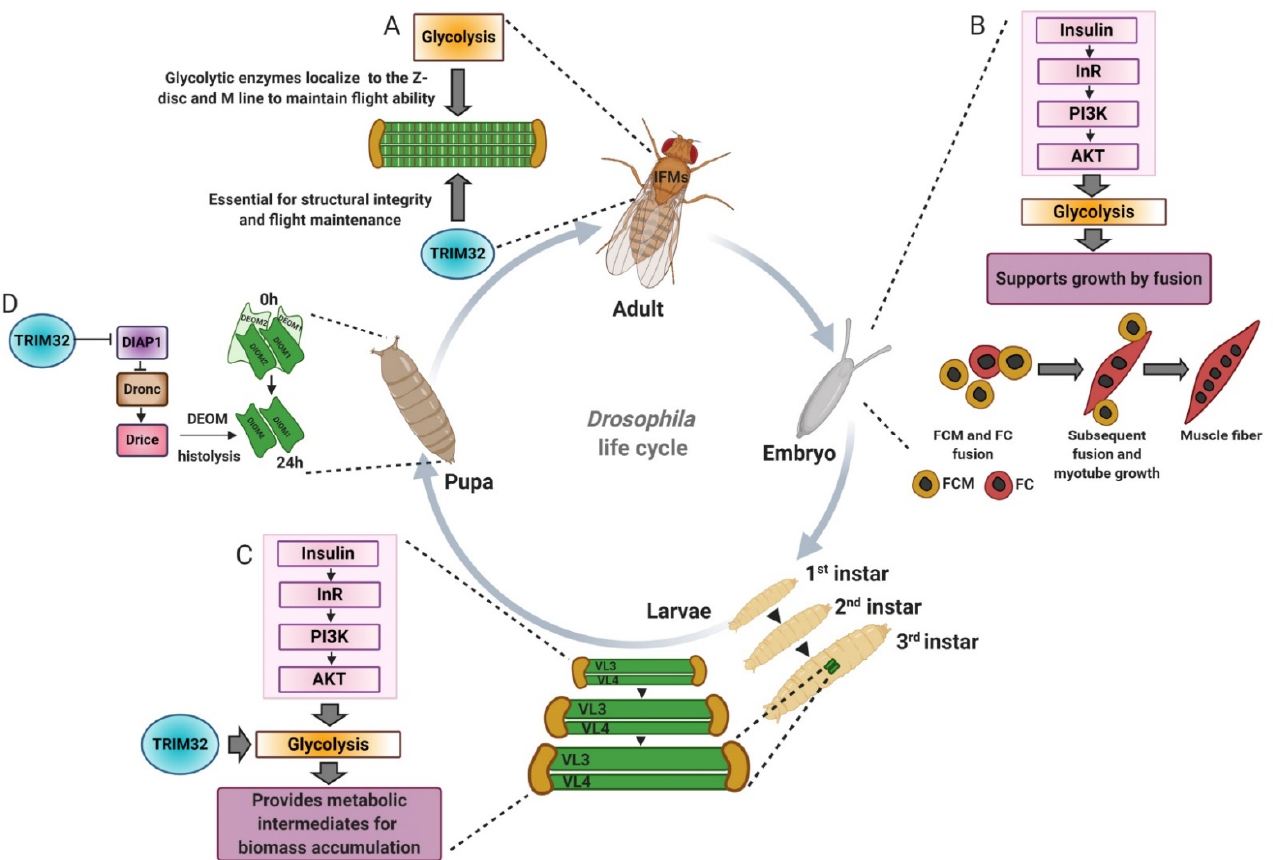
Figure 6. The Drosophila model has been instrumental in understanding how TRIM32 and glycolysis regulate cell growth and cell death. ( A ) Glycolytic enzyme localization to the Z-disc and M-line in Drosophila adult indirect flight muscles (IFMs) is required for flight maintenance. TRIM32 is also required to maintain the structural integrity of the IFMs, possibly by mediating the subcellular distribution and/or stability of glycolytic enzymes. ( B ) Insulin acts upstream of glycolysis to promote muscle growth by fusion during embryonic development. ( C ) TRIM32 directly acts on glycolytic enzymes to regulate protein levels and/or protein localization, which in turn allows for high glycolytic flux in larval tissues undergoing massive cell growth. ( D ) Much like that of XIAP, TRIM32 regulates the levels of DIAP1 to control the apoptotic death of a set of muscles that undergo histolysis during pupal development. DEOM, dorsal external oblique muscle. FCM, fusion competent myoblasts. FC, founder cells.